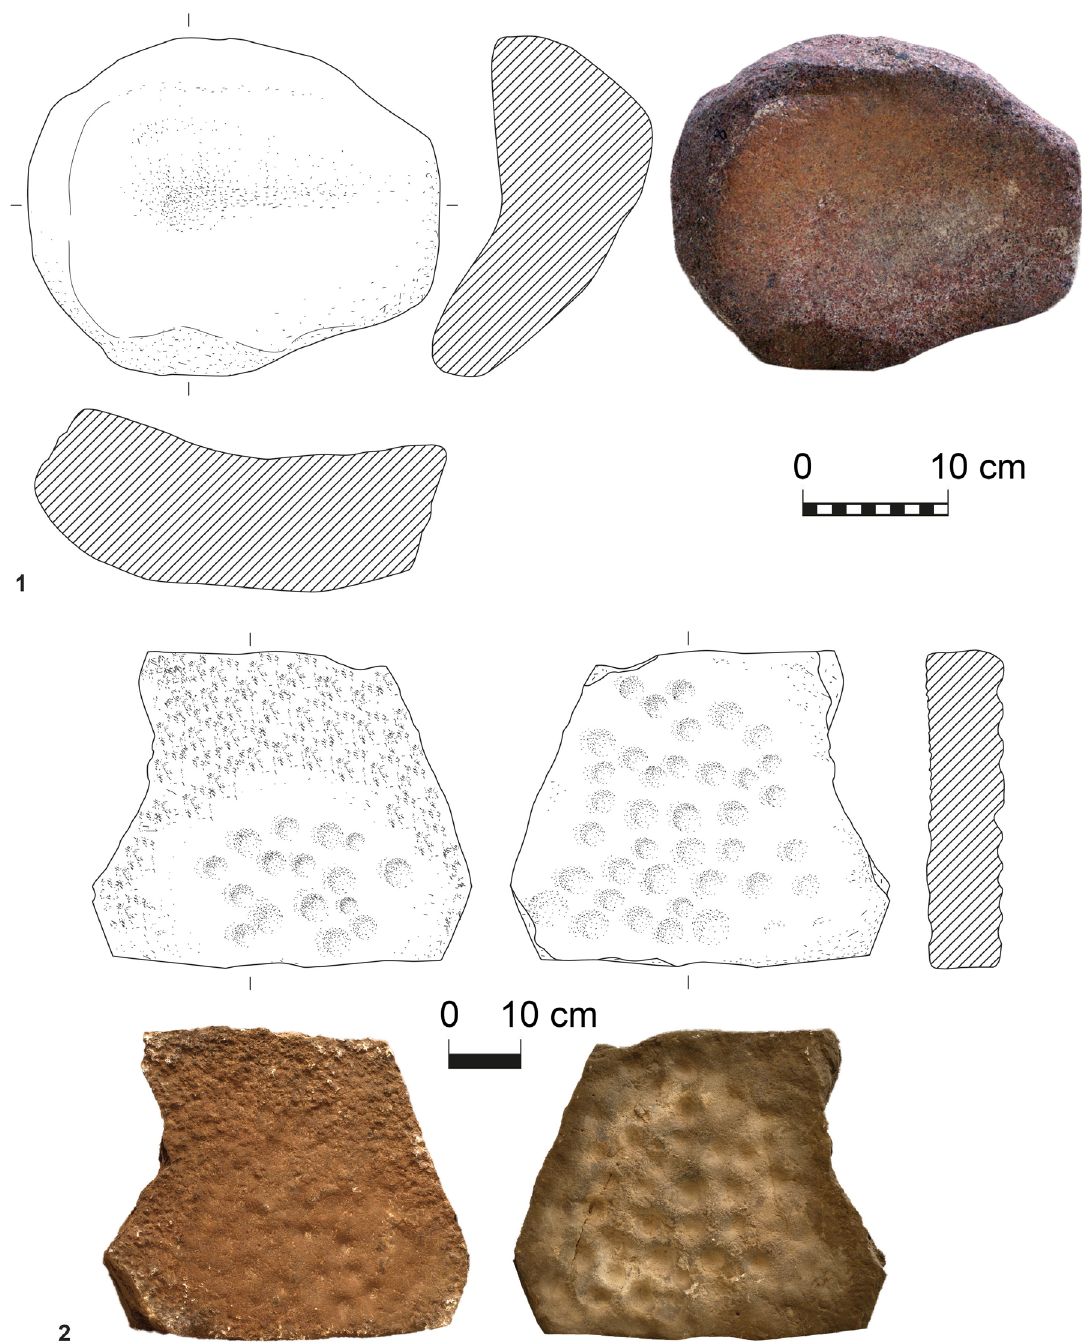
Figure 10. (1) B.8 (survey): large granite mortar boulder; (2) B.6 (survey): dolomite anvil with multiple cup marks on both